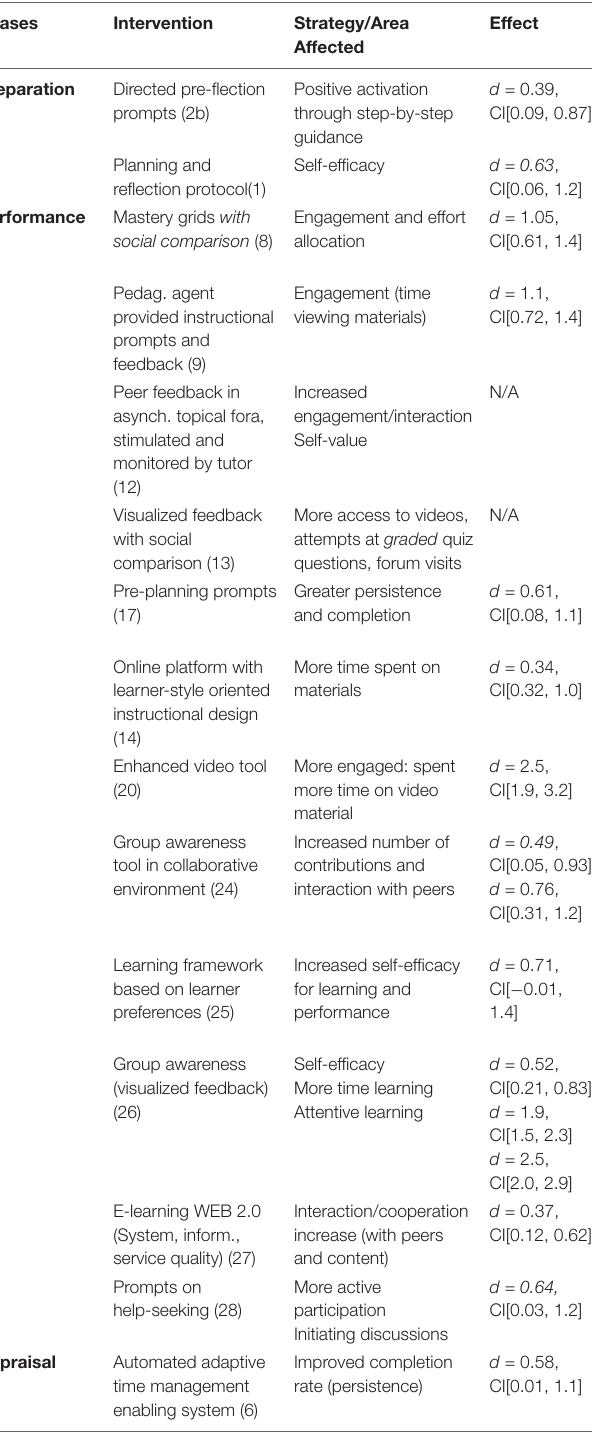
TABLE 5 | Motivation regulation support interventions and areas